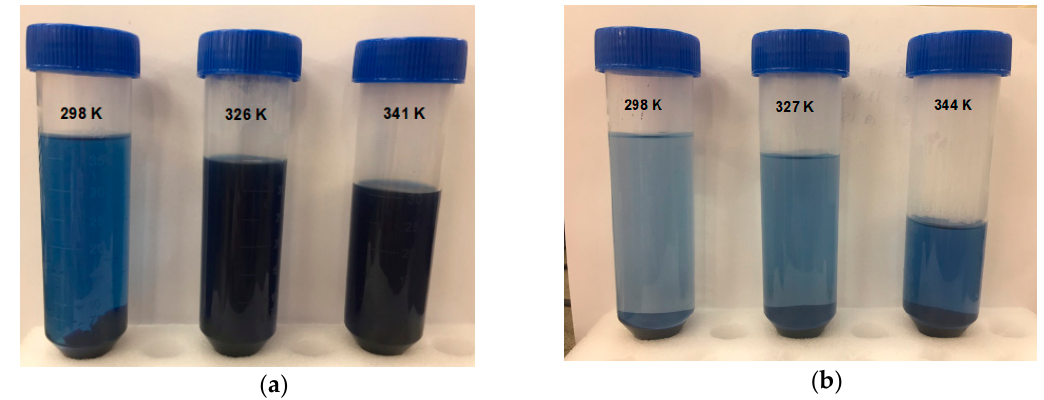
Figure 8. The effect of temperature for the adsorption of Direct Blue 78 onto chitosan-NaOH ( a ) and β -CDs-EPI ( b ) polymers at a concentration of 250 mg/L at different temperatures.